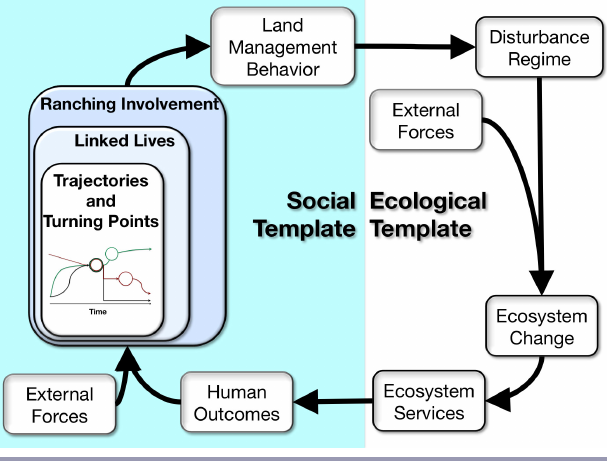
Fig. 1 . Integrating the life course perspective with Collins et al. ’s (2011) social-ecological framework. Involvement in natural resource management is a function of external forces (e.g., markets), outcomes from changes to ecosystem, as well as internal dynamics such as generational